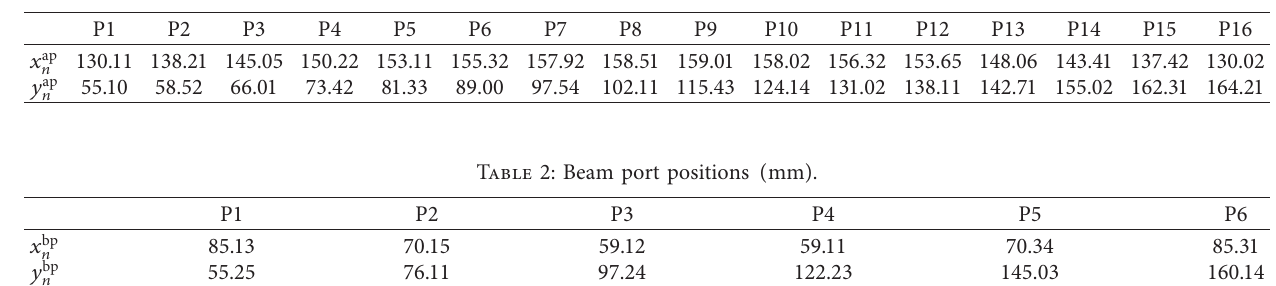
Figure 20: X-band Rotman lens prototype: port positions and position tolerances after IA refinement. Table 1: Array port positions ( mm ) .